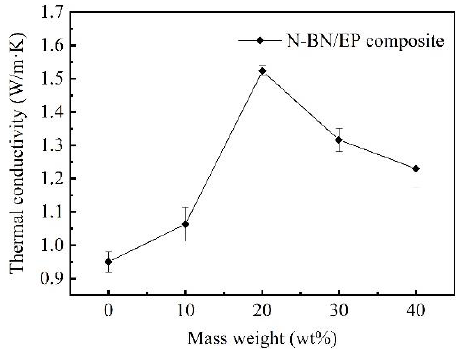
Figure 3. Thermal conductivity curve of BN/EP composite.